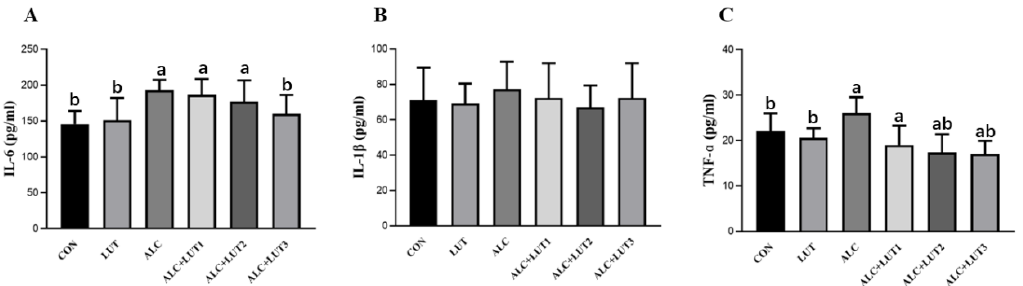
Figure 5. Changes in levels of inflammatory markers in testicular tissue. ( A ) Interleukin (IL)-6